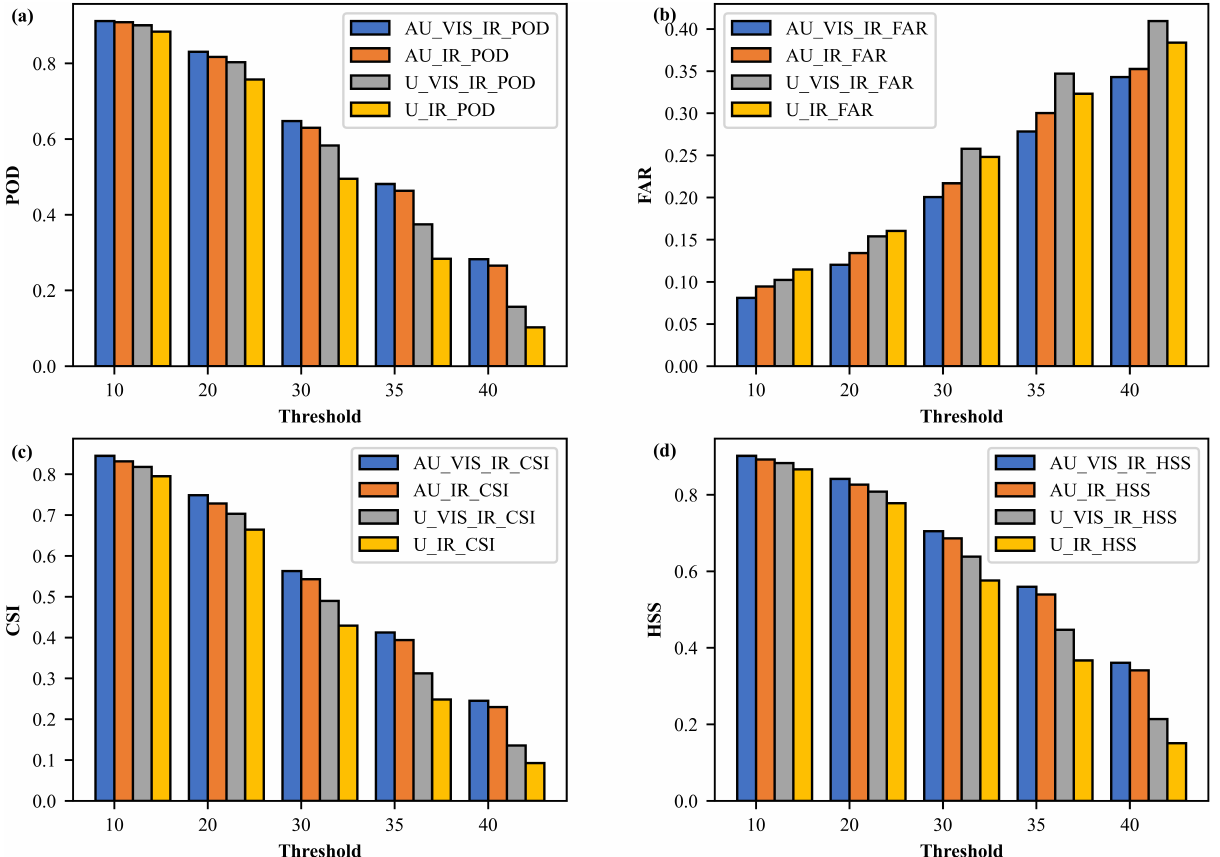
Figure 6. Classification metrics of four models in different radar echo thresholds. ( a ) POD; ( b ) FAR; ( c ) CSI; ( d ) HSS. AU_VIS_IR is the Attention U-Net VIS+IR model, AU_IR is the Attention U-Net IR-only model, U_VIS_IR is the U-Net VIS+IR model, and U_IR is the U-Net IR-only